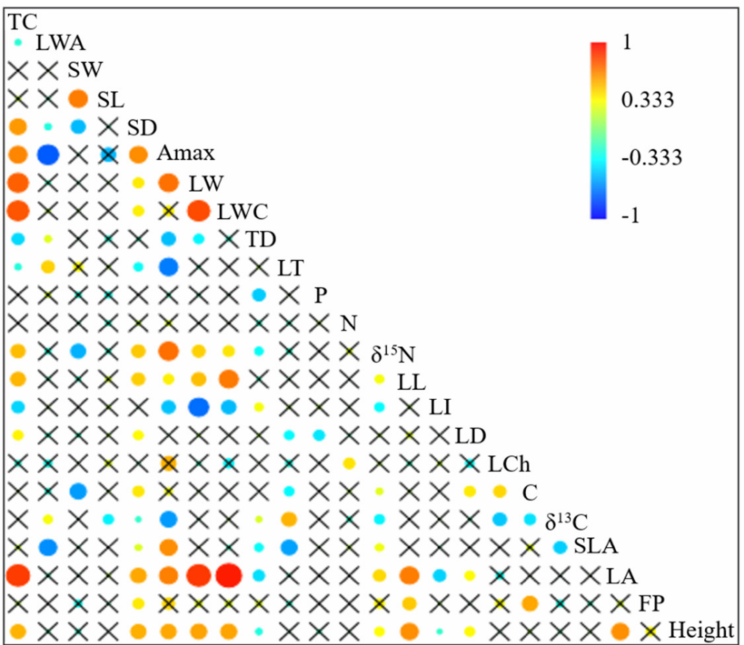
Figure 3. Spearman rank order correlations. Height = adult plant height; FP = force to punch; LA = leaf area; LD = leaf dry matter content; SLA = specific leaf area; δ 13 C = leaf carbon isotope signature; C = leaf carbon content per leaf dry mass, LCh = leaf chlorophyll content per leaf dry mass; LI = leaf index (leaf length/leaf width); LL = leaf length; δ 15 N = leaf nitrogen isotope signature; N = leaf nitrogen content per leaf dry mass; p = leaf phosphorus content per leaf dry mass; LT = leaf thickness, TD = leaf trichomes density, LWC = total leaf water content, LW = leaf width, A max = light saturated photosynthetic rate per leaf area; SD = abaxial stomatal density; SL = stomatal length; SW = stomatal width; LWA = leaf water content on area basis; TC = tank capacity. Crossed out correlations have p > 0.05. p values and Spearman’s correlation coefficients are shown in Table S3.